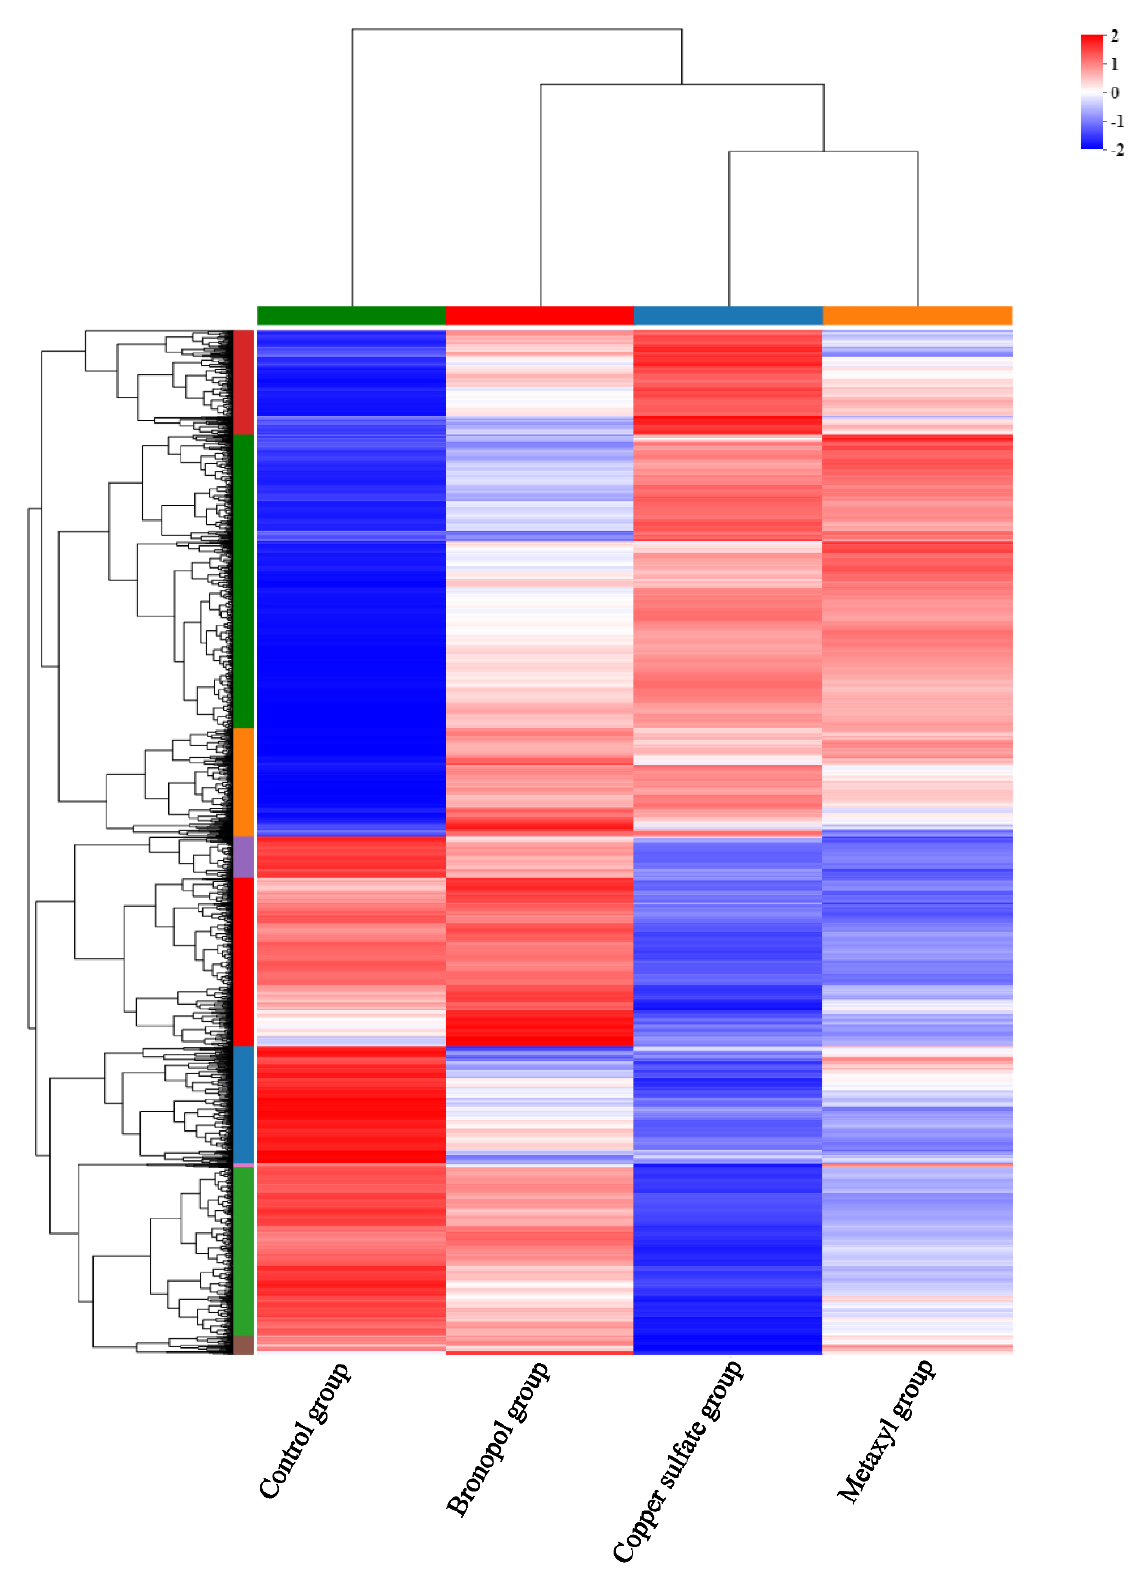
Figure 3. Heatmap presents the gene expression profile for Saprolegnia parasitica treated with metalaxyl, bronopol and copper sulfate. Red: upregulated genes; green: downregulated genes. Each line represents one gene.